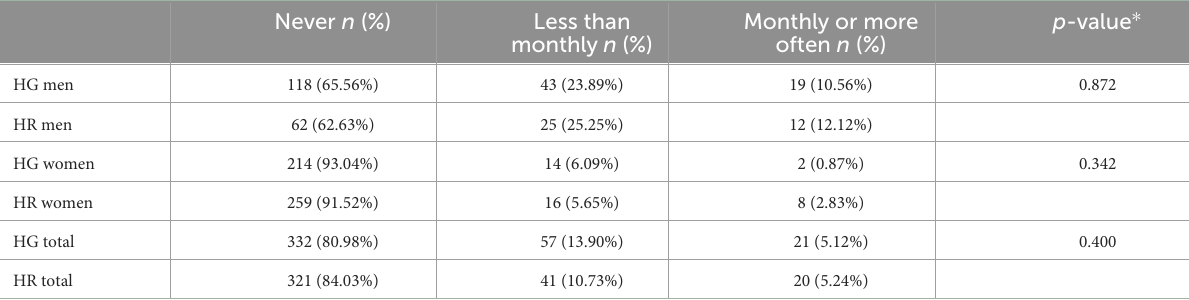
TABLE 3 The prevalence of consuming six or more drinks of alcohol per occasion (AUDIT question 3) among the Hungarian general and Roma populations, by gender.